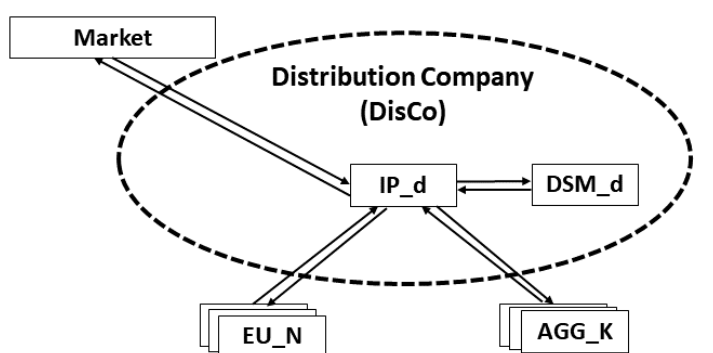
Figure 3. Organization of the DisCo